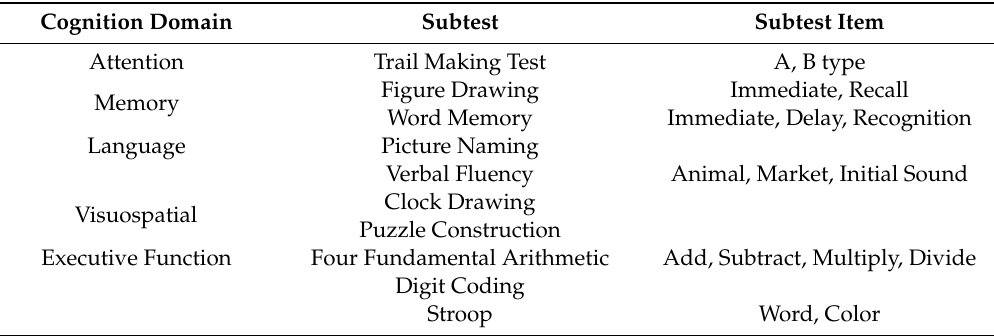
Table 1. Cognition area construction of Co-Wis.